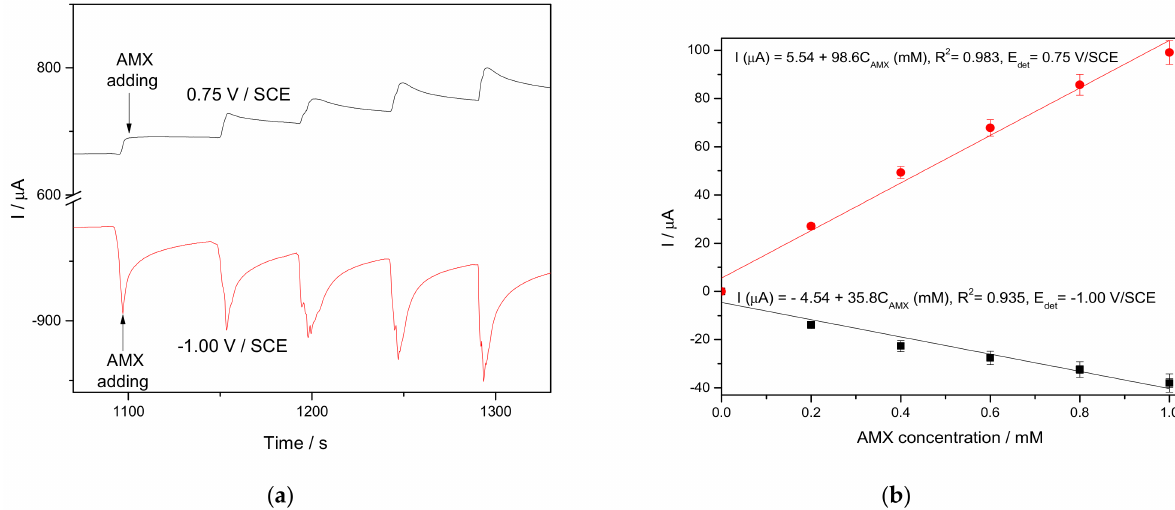
Figure 11. ( a ) Multiple-pulsed amperograms recorded at CuBi/CNF paste electrode in 0.1 M Na 2 SO 4 supporting electrolyte in the presence of various AMX concentrations: 0.2 mM, 0.4 mM, 0.6 mM, 0.8 mM, and 1.0 mM, at two applied potential levels, i.e., +0.750 V/SCE and − 1.00 V/SCE. ( b )Calibration plots for AMX detection in the concentration range of 0.2–1.0 mM recorded at the potential +0.750 V/SCE and − 1.00